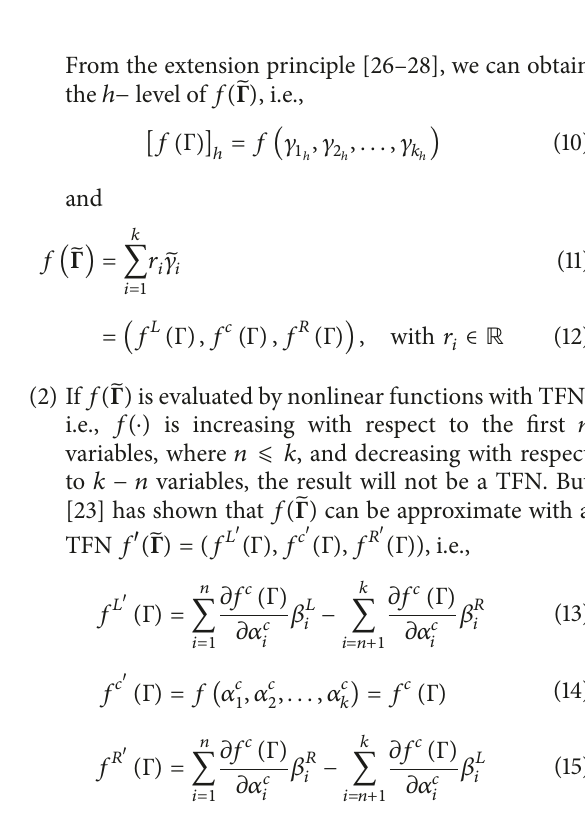
Figure 1: An example of Asymmetric Triangular Fuzzy Number ( ̃𝛾 𝑗 = (𝛽 𝐿 𝑗 , 𝛼 𝑐 𝑗 ,𝛽 𝑅 𝑗 )